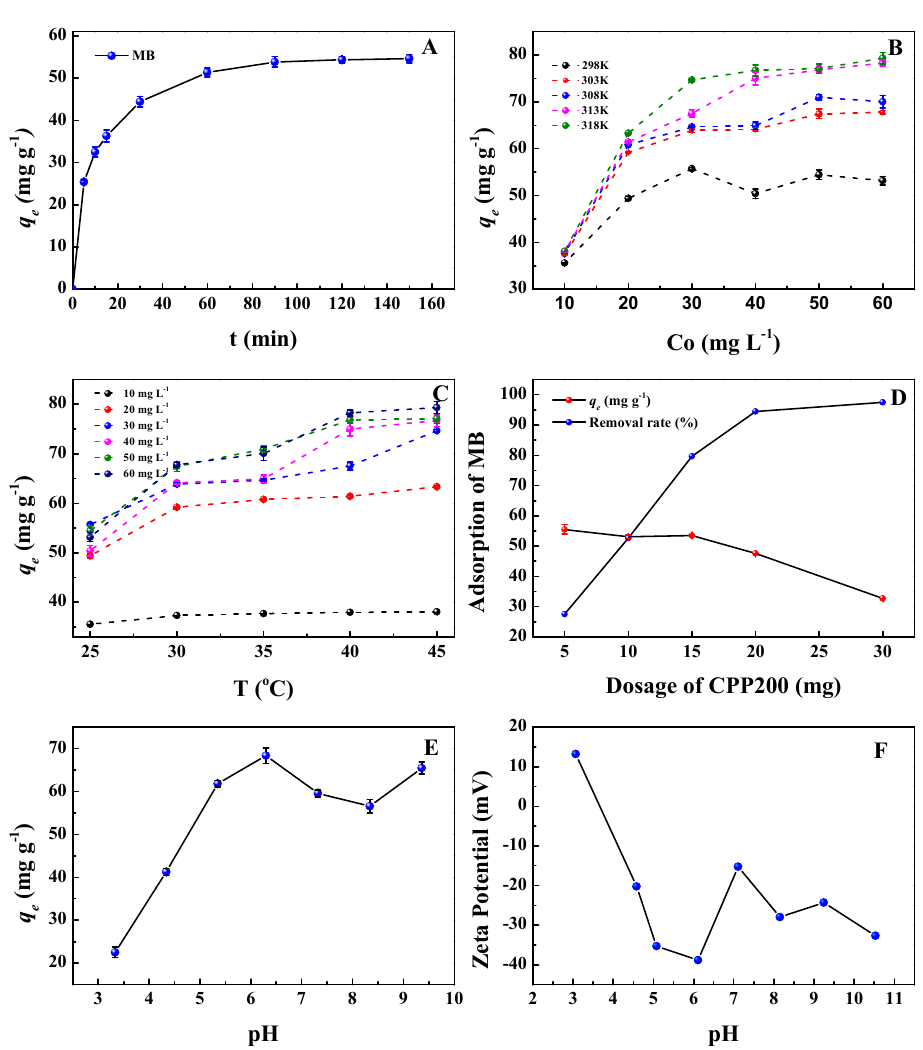
Figure 7. Adsorption properties of CPP200 for MB. ( A ) Effect of contact time ( C 0 = 50.0 mg/L, T = 25 °C, pH = 7.32); ( B , C ) effects of initial MB concentration and temperature (t = 90 min, pH = 7.32); ( D ) effect of CPP200 dosage ( C 0 = 50.0 mg/L, t = 90 min, pH = 7.32); ( E ) effect of initial MB pH ( C 0 = 50.0 mg/L, t = 90 min, T = 25 °C); ( F ) zeta potential of CPP200 in aqueous solution at different pH values.